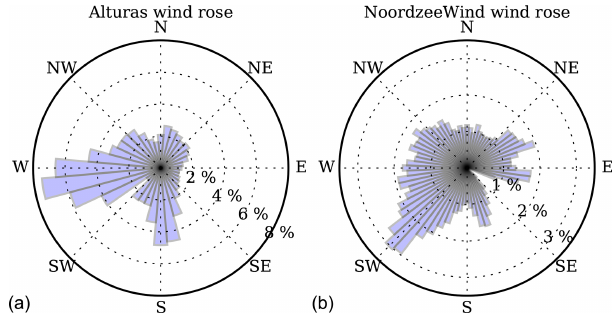
Figure 5. Panel (a) : the wind direction distribution in Alturas, Cal- ifornia, separated into 36 bins, every 10 ◦ . Panel (b) : the wind direc- tion distribution of the NoordzeeWind meteorological mast, sepa- rated into 72 bins, every 5 ◦ .